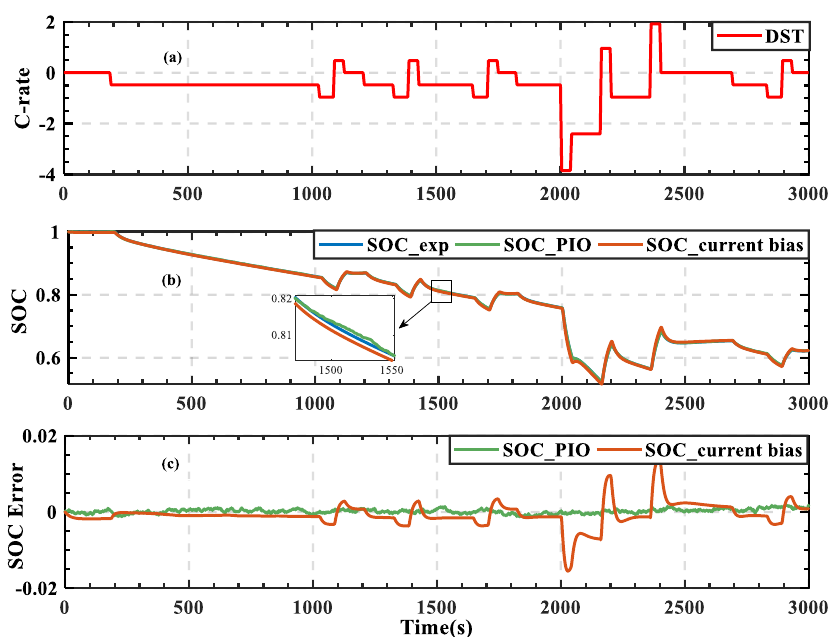
Figure 6. Estimation results of SOC considering current bias under DST condition. ( a ) DST profile, ( b ) Results of SOC, ( c ) Errors of SOC.